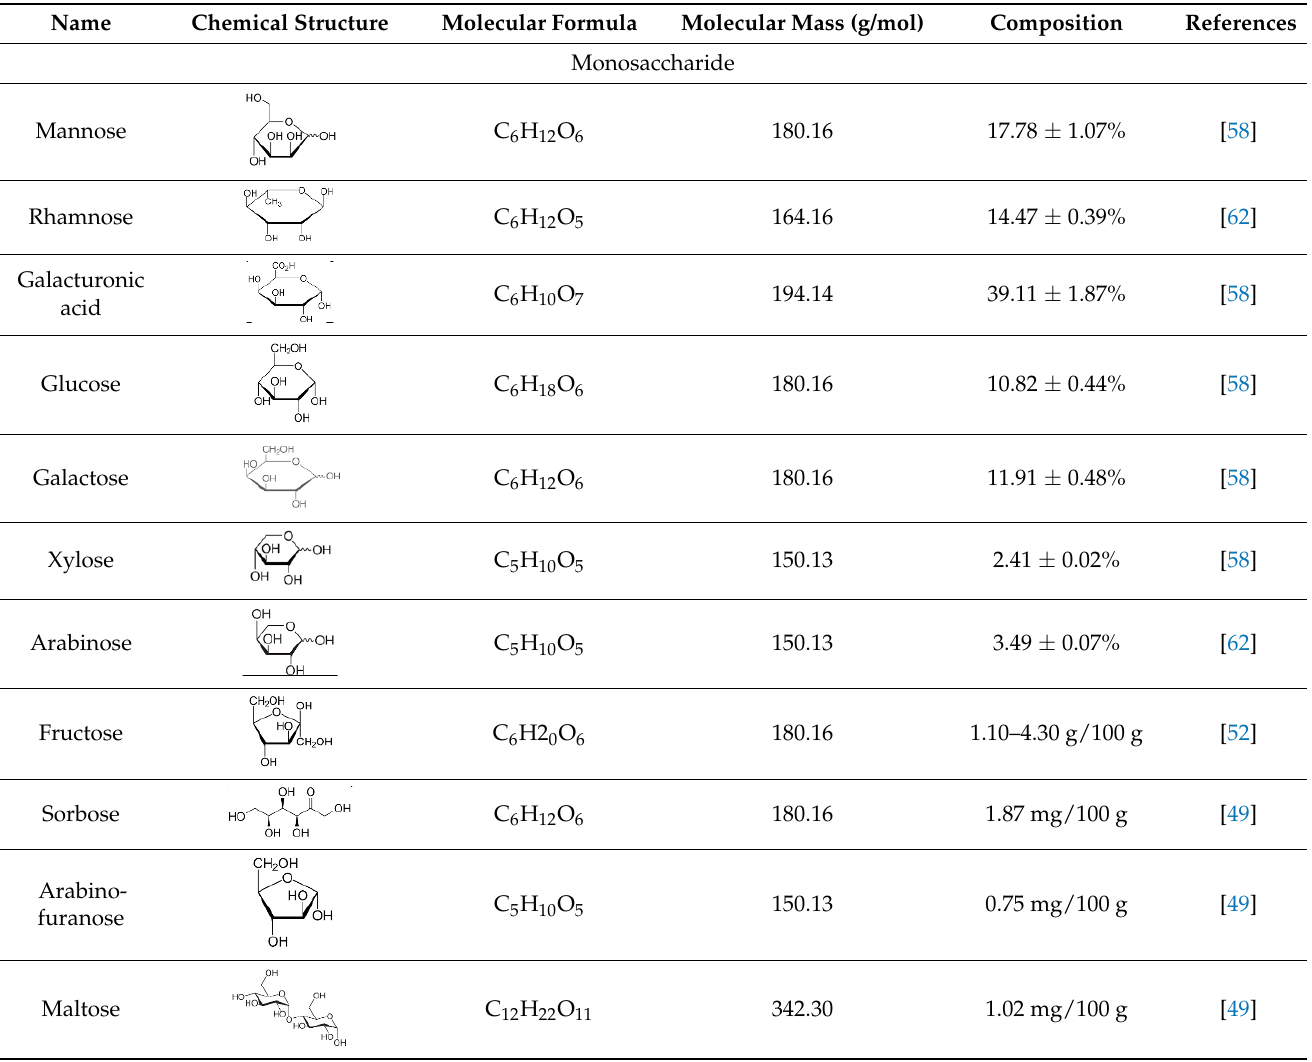
Table 4. Monosaccharide and amino acid profiles of red pitaya. Table 4 Monosaccharide and amino acid profiles of red pitaya. Table 4 Monosaccharide and amino acid profiles of red pitaya. Table 4 Monosaccharide and amino acid profiles of red pitaya. Table 4 Monosaccharide and amino acid profiles of red pitaya. Table 4 Monosaccharide and amino acid profiles of red pitaya. Table 4 Monosaccharide and amino acid profiles of red pitaya. Table 4 Monosaccharide and amino acid profiles of red pitaya. Table 4 Monosaccharide and amino acid profiles of red pitaya. Table 4 Monosaccharide and amino acid profiles of red pitaya. Table 4 Monosaccharide and amino acid profiles of red pitaya. Table 4 Monosaccharide and amino acid profiles of red